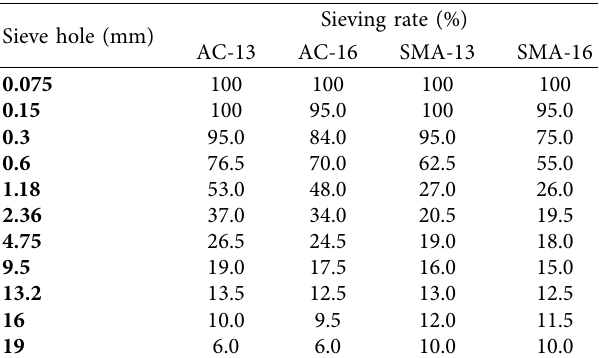
Table 1: Mineral aggregate grading of asphalt concrete mixtures (square